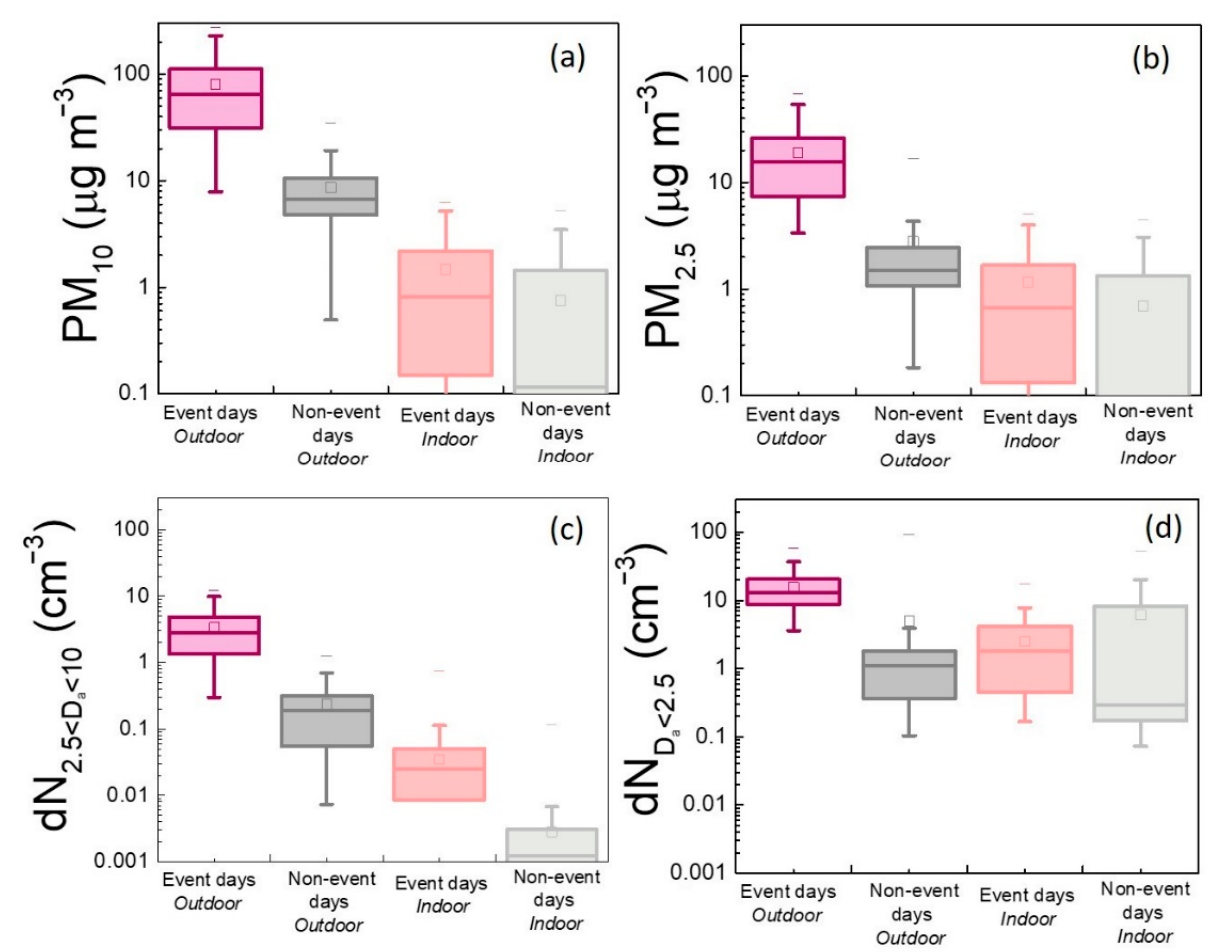
Figure 7. Box charts of PM 10 ( a ), PM 2.5 ( b ), particle number concentration of coarse particles (dN 2.5<D<10 ) ( c ) and particle number concentration of fine particles (dN D<2.5 ) ( d ) during event and non-event days in indoor and outdoor air.